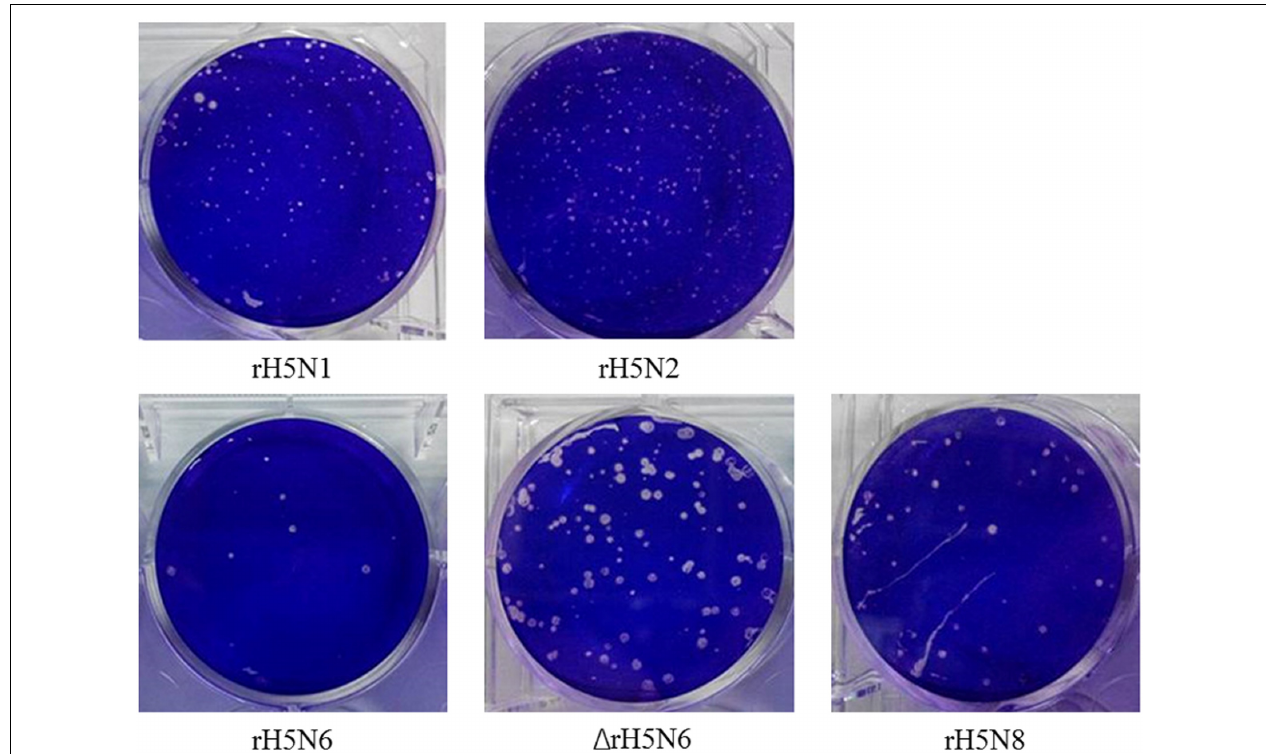
FIGURE 3 | Plaque-forming ability of H5Nx reassortant viruses in MDCK cell monolayers. Cells were infected with rH5N1, rH5N2, rH5N6, (cid:49) rH5N6, and rH5N8 virus. At 2 h.p.i., cells were washed twice with PBS and then overlaid with MEM containing 1% agarose. After 48–72 h of incubation at 37 ◦ C, plaques were